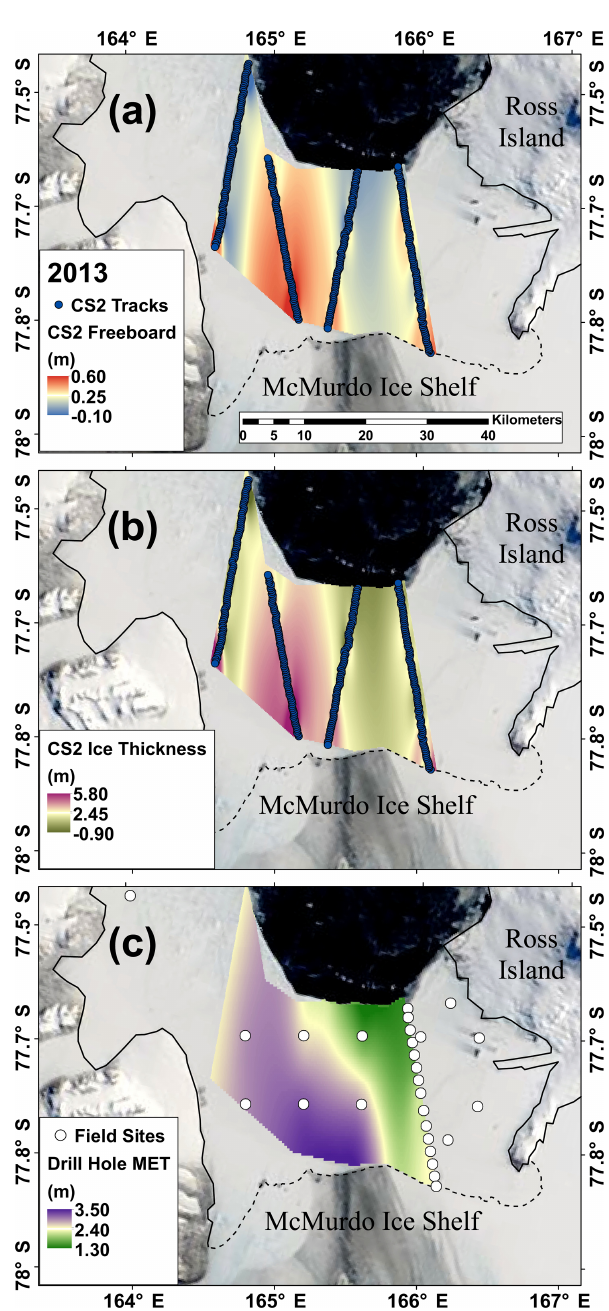
Figure 5. CS2 freeboard was higher and CS2 ice thickness greater where supercooled ISW outflows in McMurdo Sound. Spline- interpolated maps of the distributions of (a) CS2 freeboard, (b) CS2 ice thickness from four tracks over first-year fast ice and (c) inter- polated drill hole MET measured at field sites in November 2013. A running mean of three CS2 freeboard and CS2 ice thickness mea- surements (corresponding to ∼ 1km) was applied along the track prior to applying the interpolation in panels (a) and (b) (satellite image: NASA MODIS, 19 November